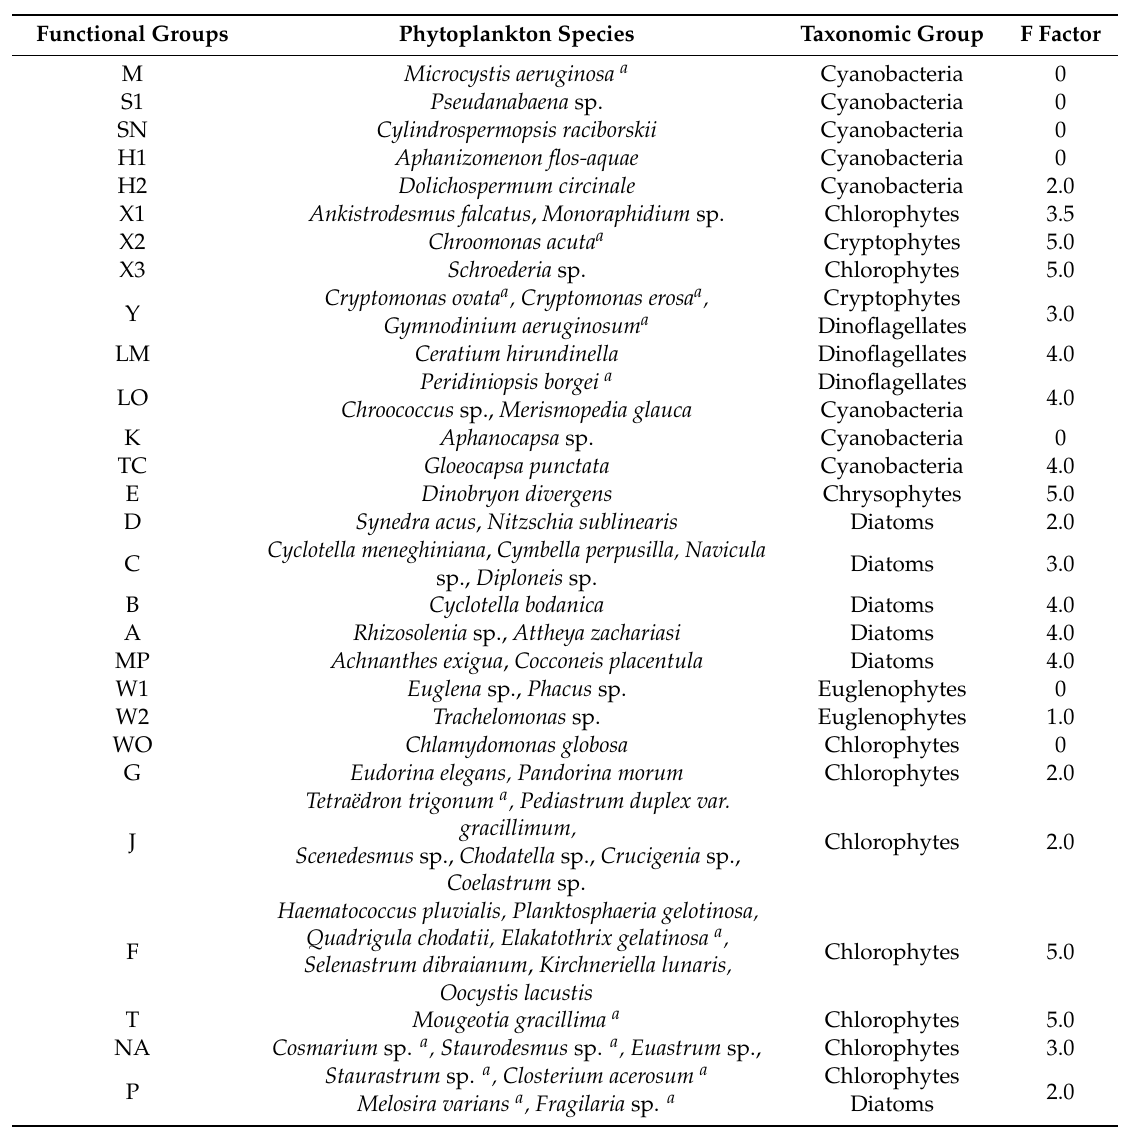
Table 2. Main phytoplankton taxa, functional groups, and respective F factors in the samples collected from the Gaozhou Reservoir from 2015 to